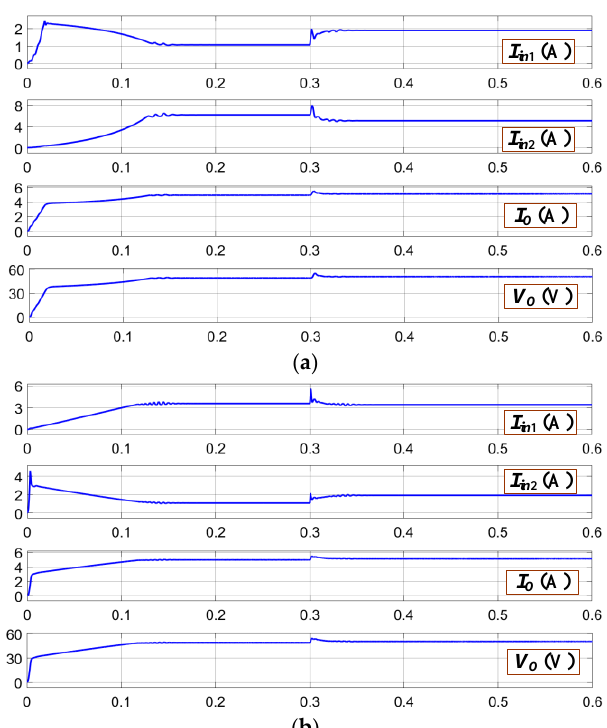
Figure 10. Simulation results of the discharging scenario ( a ) Case I; ( b ) Case II.